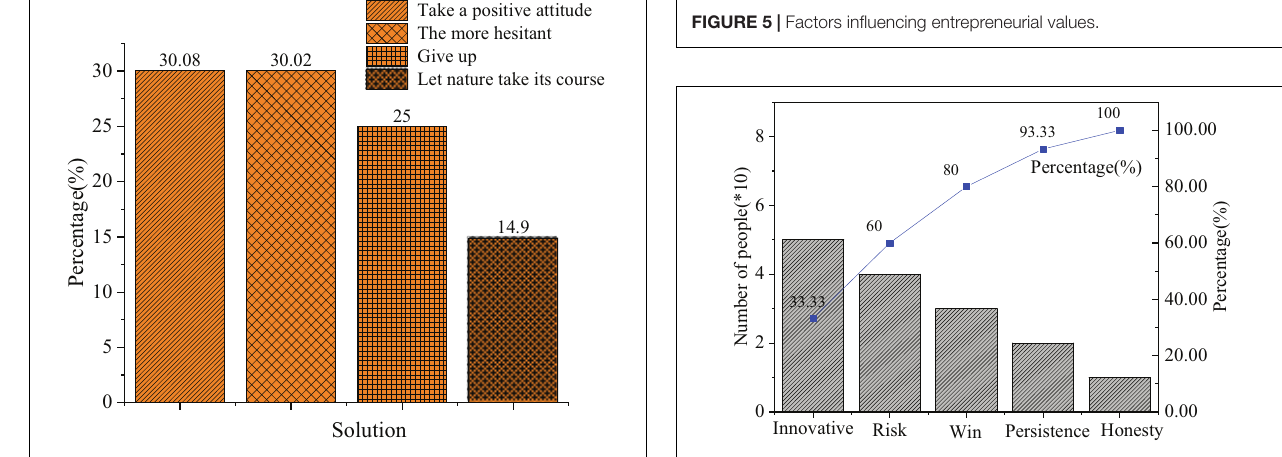
FIGURE 3 | Solutions against entrepreneurial risks.